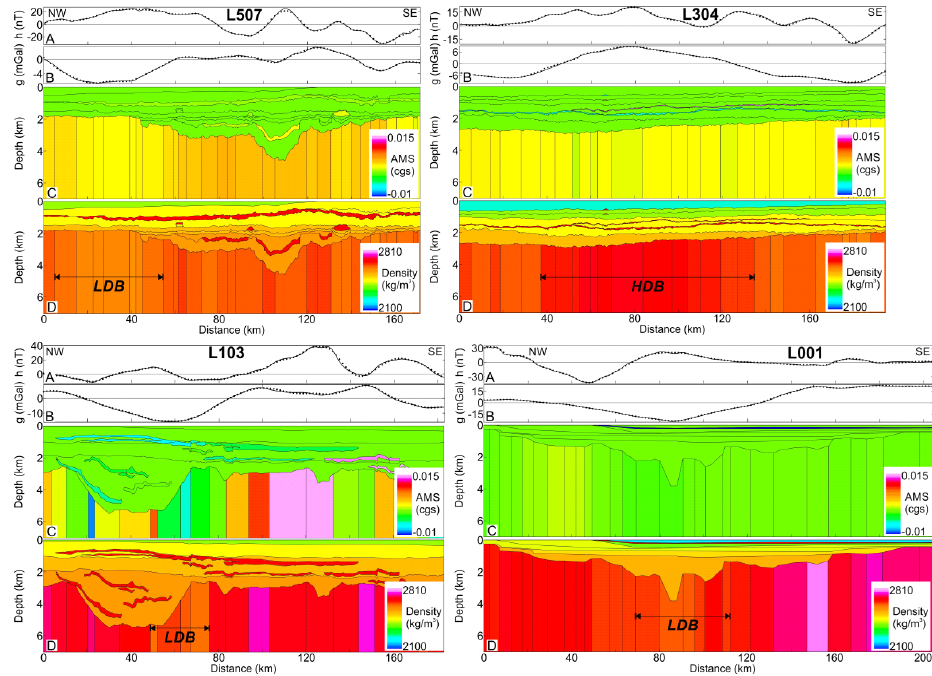
Figure 13. Joint modeling of residual reduced-to-pole magnetic (a) and gravity (b) anomalies along seismic profiles. Final adjusted mag- netic (c) and gravity (d) models. HDB: high-density crustal block; LDB: low-density crustal